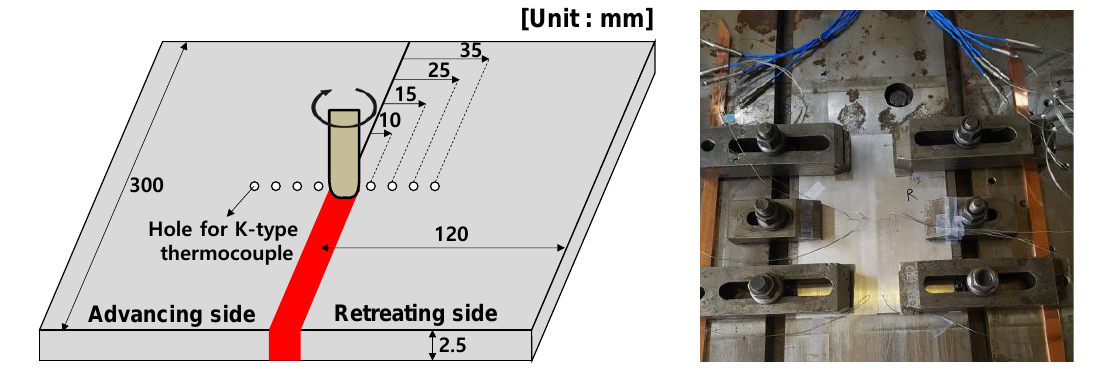
Figure 4. Configuration of FSW experiment.